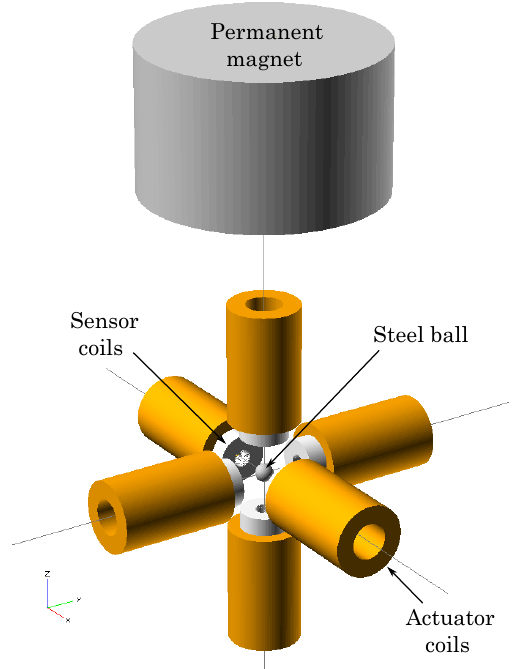
Figure 2. Computer-aided design (CAD) model showing the ball, permanent magnet, actuator coils and sensor coils.